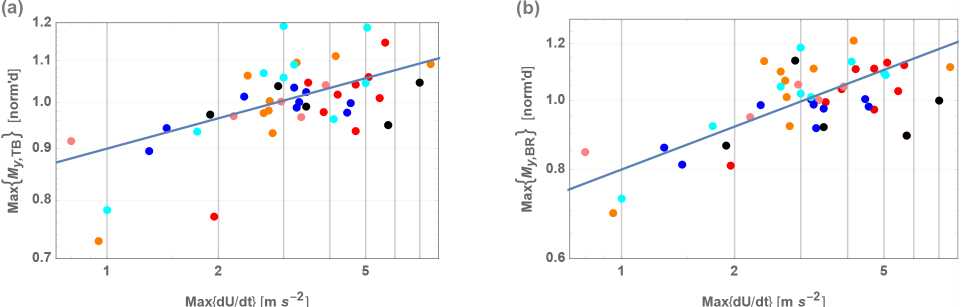
Figure 25. Maximum loads ( M tbfa on the left and M brfw on the right) versus maximum acceleration: all cases and turbines where speed exceeds rated speed. Load values normalized by mean of all points to protect proprietary information. Colors correspond to cases following previous figures. Lines indicate sensitivity: log–log slope of 0.1 on the left and 0.2 on the